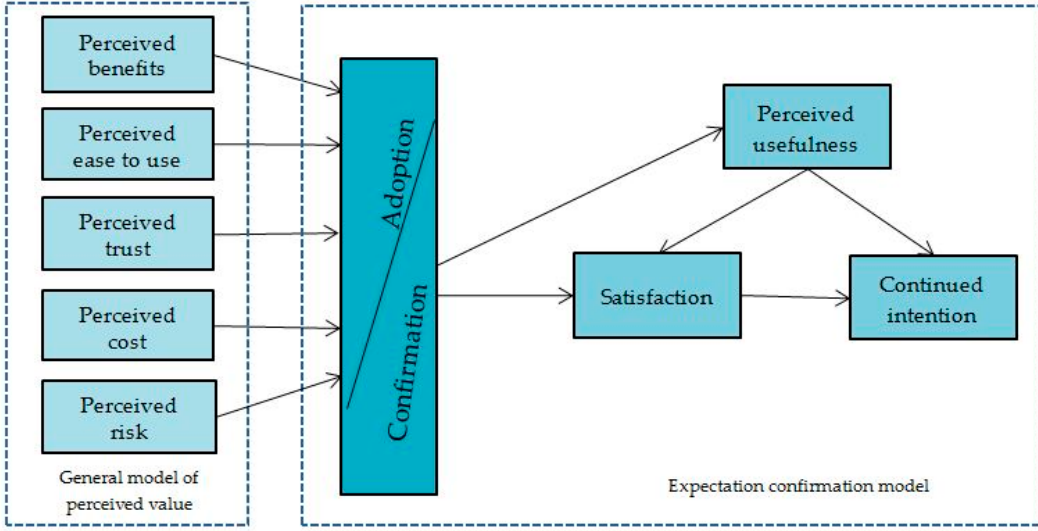
Figure 1. A Proposed integrated model for adoption and continuing